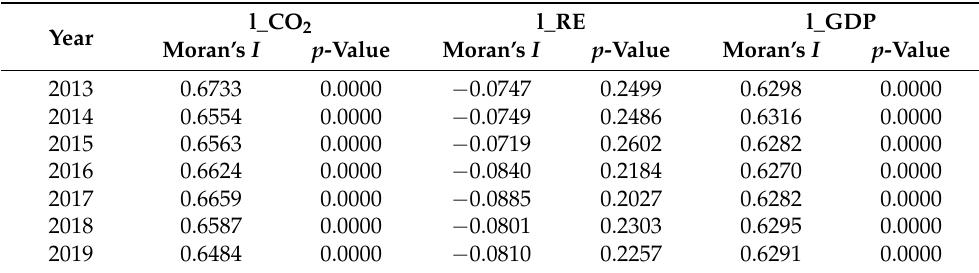
Table 1. Spatial autocorrelation tests for the variables considered in years 2013–2019.